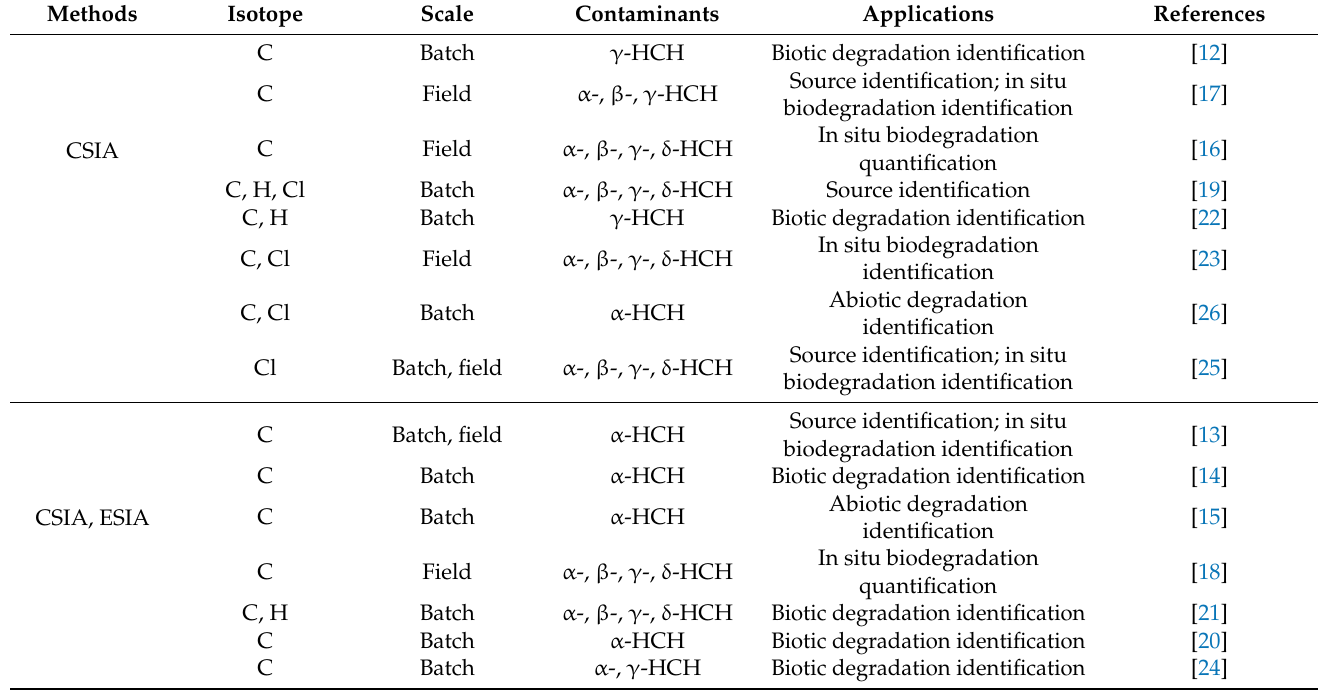
Table 1. Recent applications of CSIA and ESIA in the HCHs